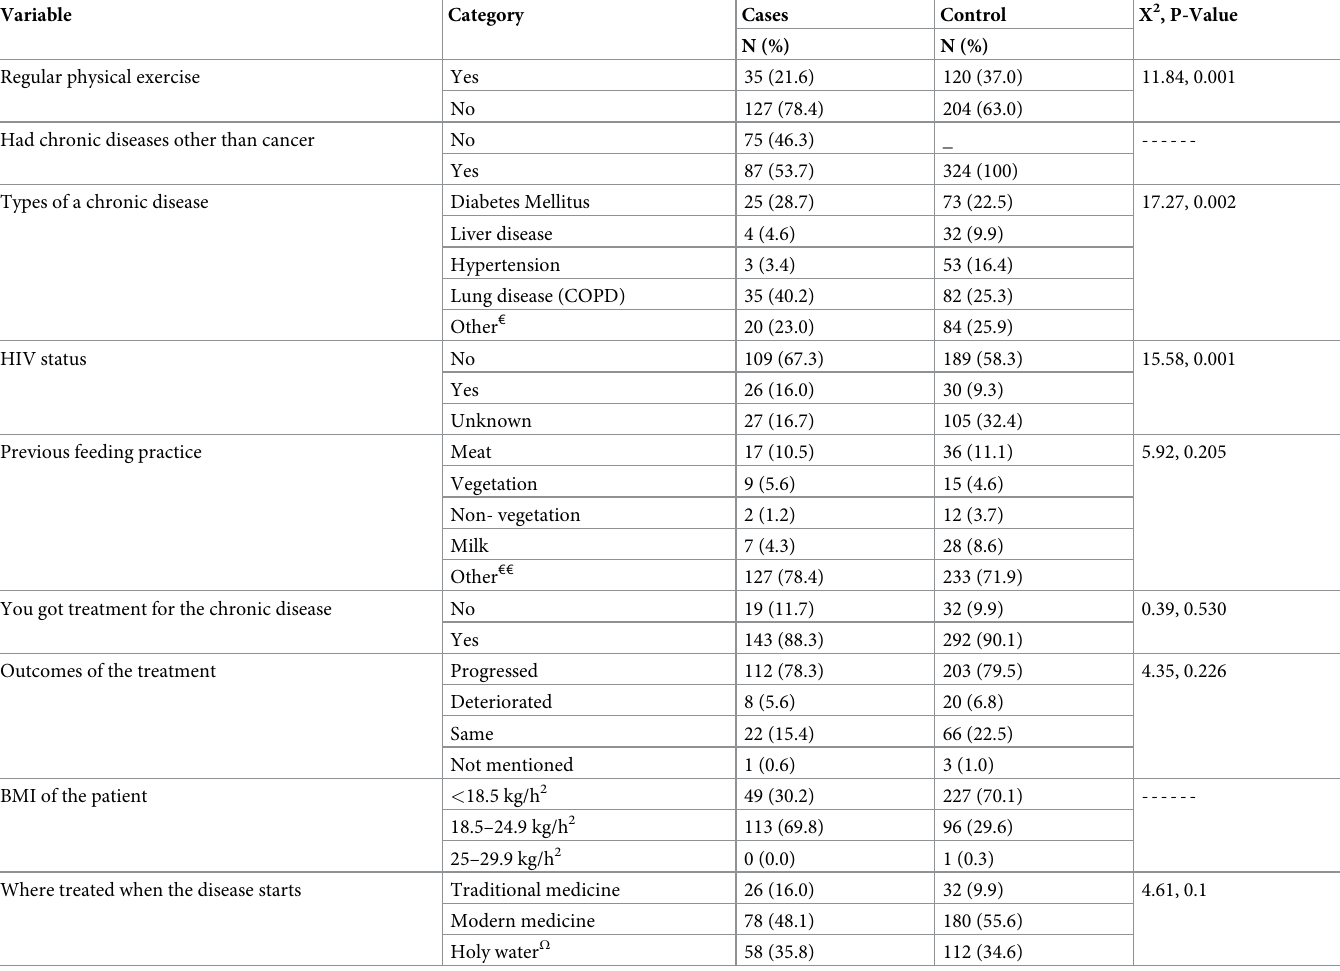
Table 4. Behavioral and feeding practice-related characteristics of the respondents at Felegehiwot specialized hospital, northwest Ethiopia,